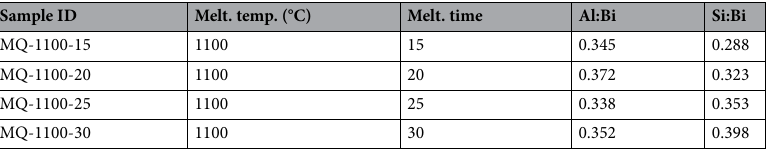
Table 1. List of the synthesized glassy samples with the process parameters (melting temperature and time) and the relative atomic content of Al and Si dopants.